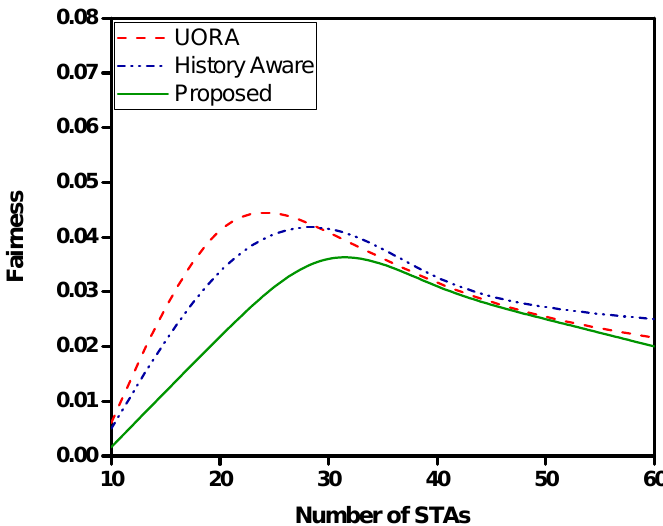
Figure 6. Fairness in RU allocation. The lower the value is , fairer the RU allocation will be.